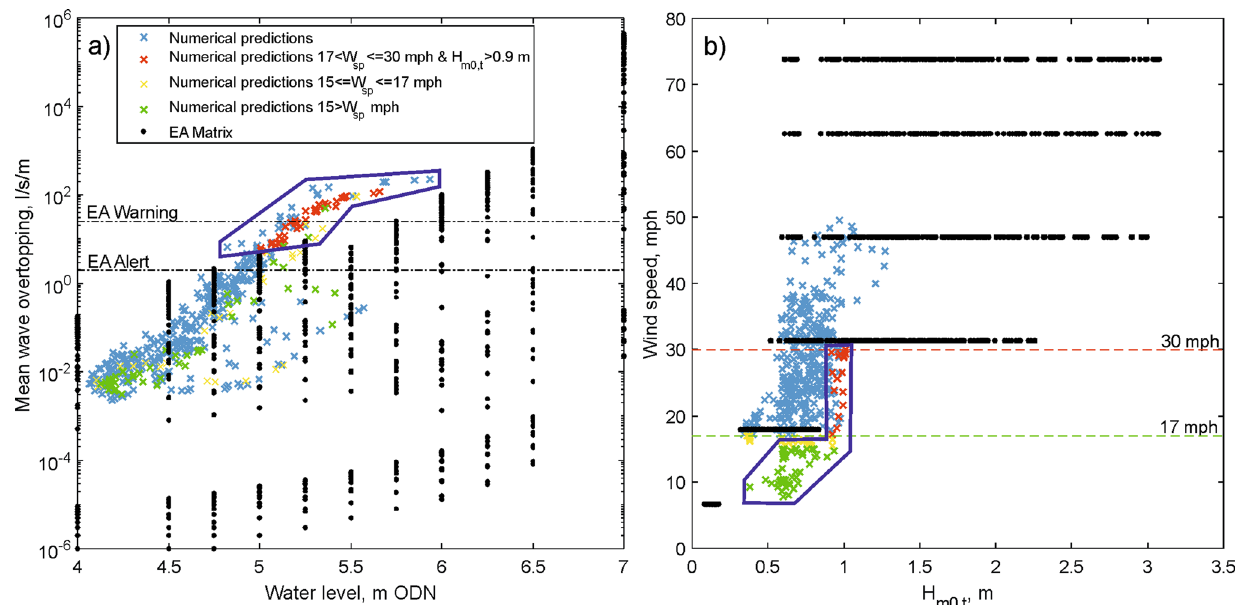
Figure 4. The EA matrix (black) and our overtopping predictions for different wind speeds (W sp ) as shown in the key. ( a ) Overtopping discharges for different water levels. The blue polygon indicates the hazardous Facebook events that are under predicted in the EA matrix. ( b ) The range of wave and wind conditions considered. The blue polygon highlights the wave conditions (green, yellow and red crosses) which can produce hazardous overtopping when water levels exceed 5 m AOD, but are out of range in the